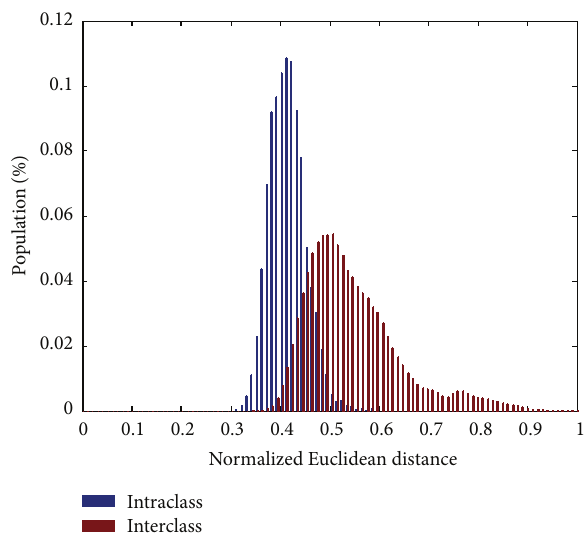
Figure 4: The Euclidean distance of extracted intra- and interclass feature vectors.